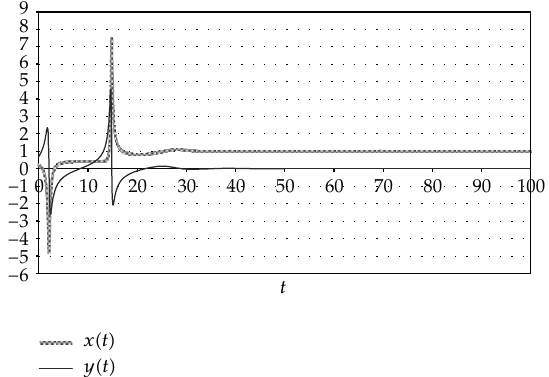
Figure 6: x (cid:2) 0 (cid:3) (cid:6) 0.2, y (cid:2) 0 (cid:3) (cid:6) 0.7, a (cid:6) 0.1, b (cid:6) 0.5, alpha (cid:6)